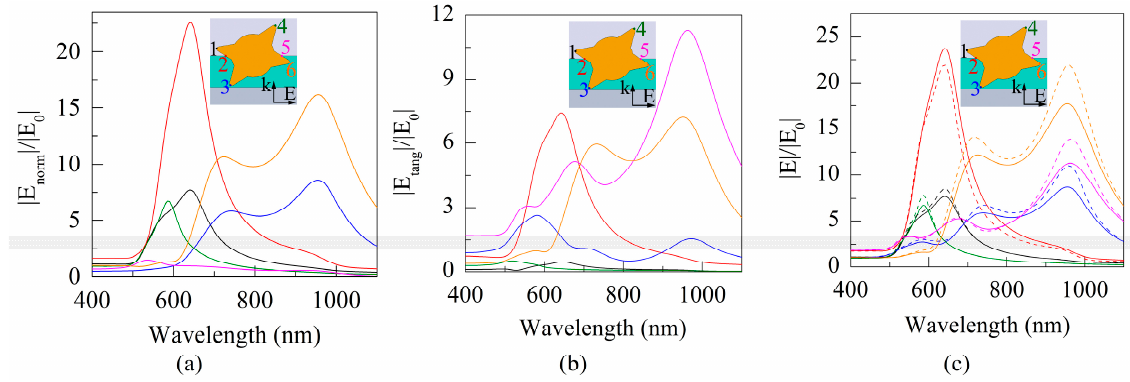
Figure 6. Spectral curves for modules of normal | E normal | ( a ), tangential | E tang | ( b ), and complete | E | ( c ) amplitudes of the electric field at six points on the GNS surface indicated in the insets. In panel ( c ), the solid and dotted curves were obtained with and without the size correction, respectively. The curves are normalized to the amplitude of the incident field | E 0 |. Field localization zones: points 1, 4 are the spike tips in vacuum; points 3, 6 are the spike tips in DLC; points 2, 5 are the exit/entry of the spikes into the DLC film. Curve colors match the point number colors.